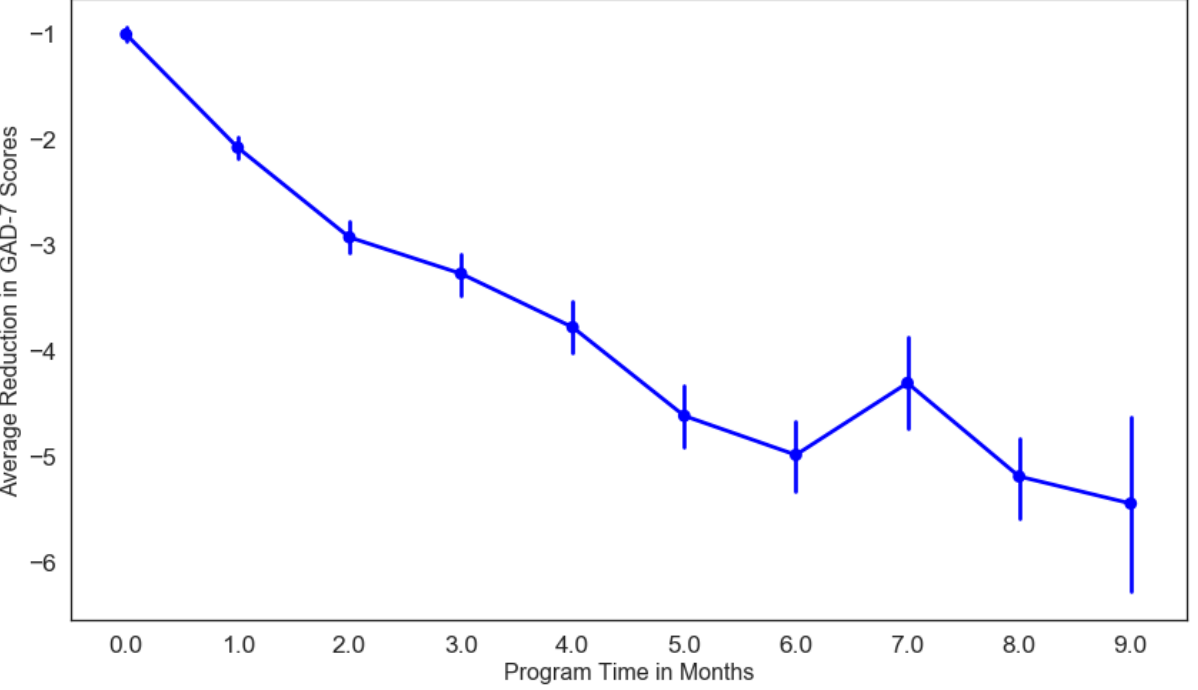
Figure 4. Estimated marginal mean of anxiety scores by cognitive behavioral therapy program time. GAD: Generalized Anxiety